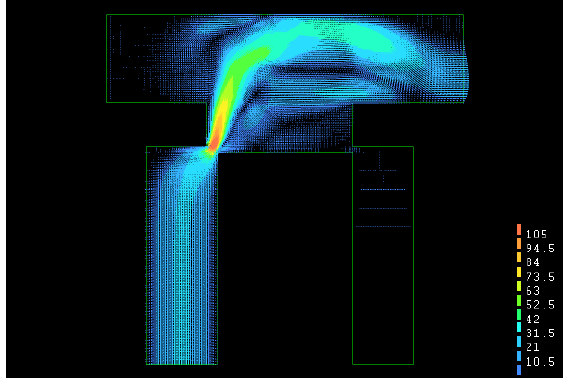
Fig. 15. Velocity profile of the modified design in a working mode without outlet nozzles